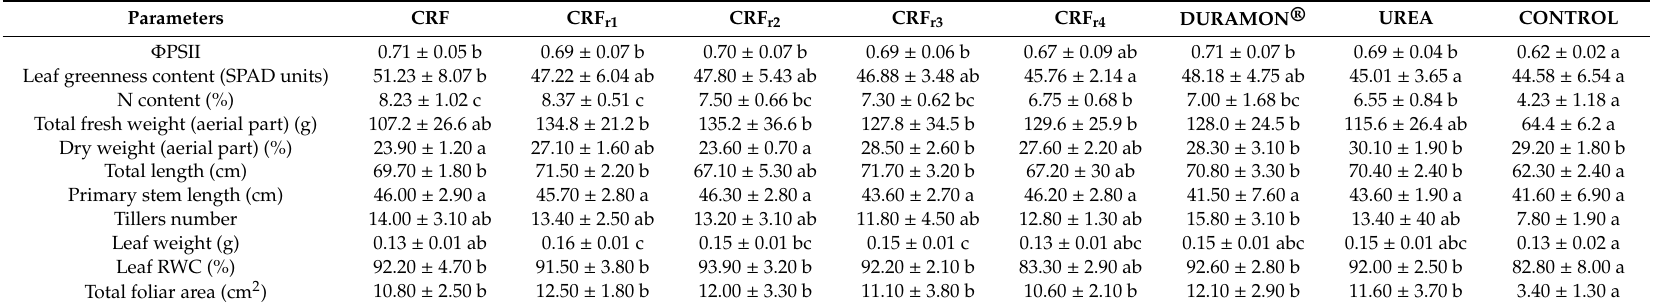
Di ff erent letters in the same row indicate significant statistical di ff erences (Tukey’s test, p <